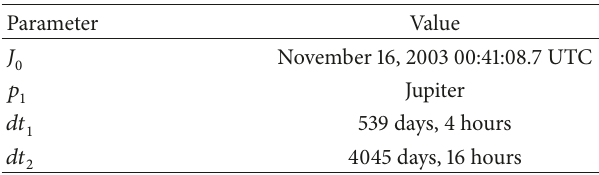
Table 11: Optimized chromosome for single planet flyby to Hidalgo.